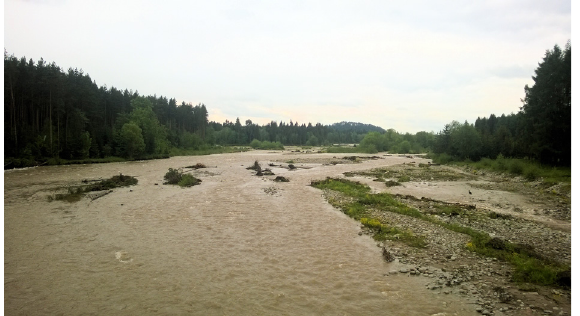
Fig. 4. The Białka river channel at the Spisz Region. Photo: A. Chrobak.